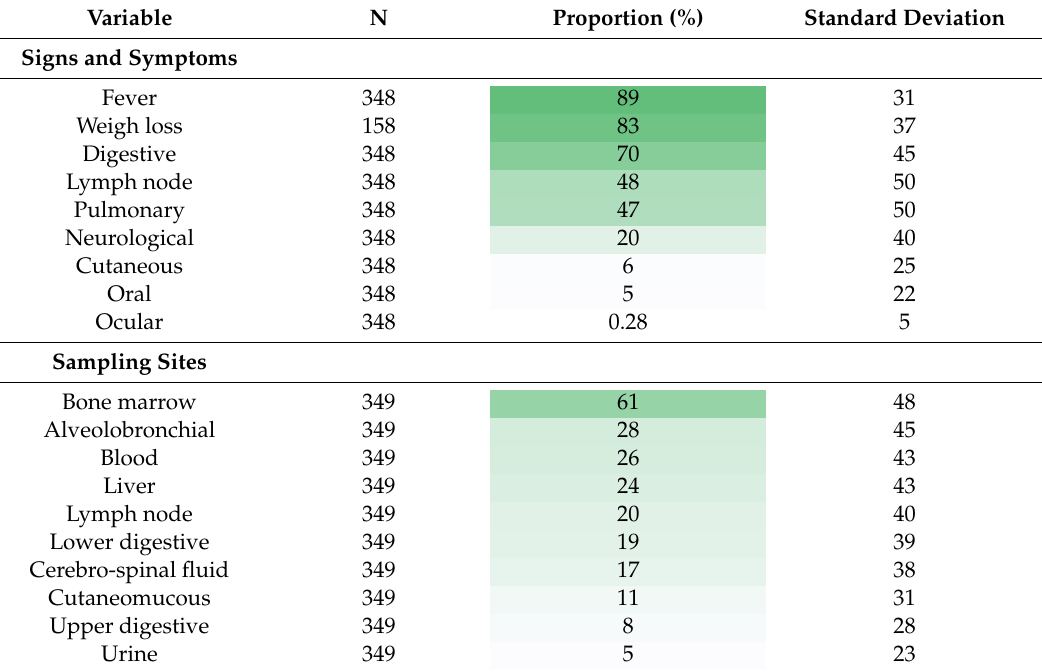
Table 1. Frequency of di ff erent signs and symptoms and sites sampled to try to identify the